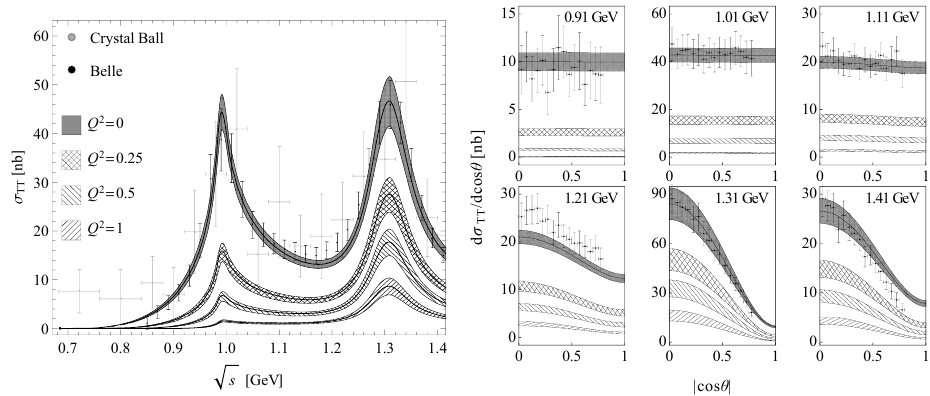
Figure 1. Total ( | cos θ | < 0 . 8) and di ff erential cross sections for the γγ ∗ → π 0 η process. The error bands reflect the uncertainties of the universal coupling VP γ , the variation of Λ S , couplings of the a 2 (1320) to γγ,πη and the variation of the TFFs as is described in Sec. 2.3. The data are taken from [3,